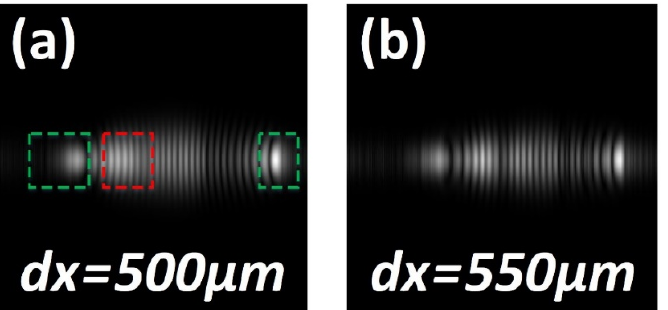
Figure 10. The output light field of the cavity with (a) 𝑑𝑥 = 500 μm and (b) 𝑑𝑥 = 550 μm , respec-